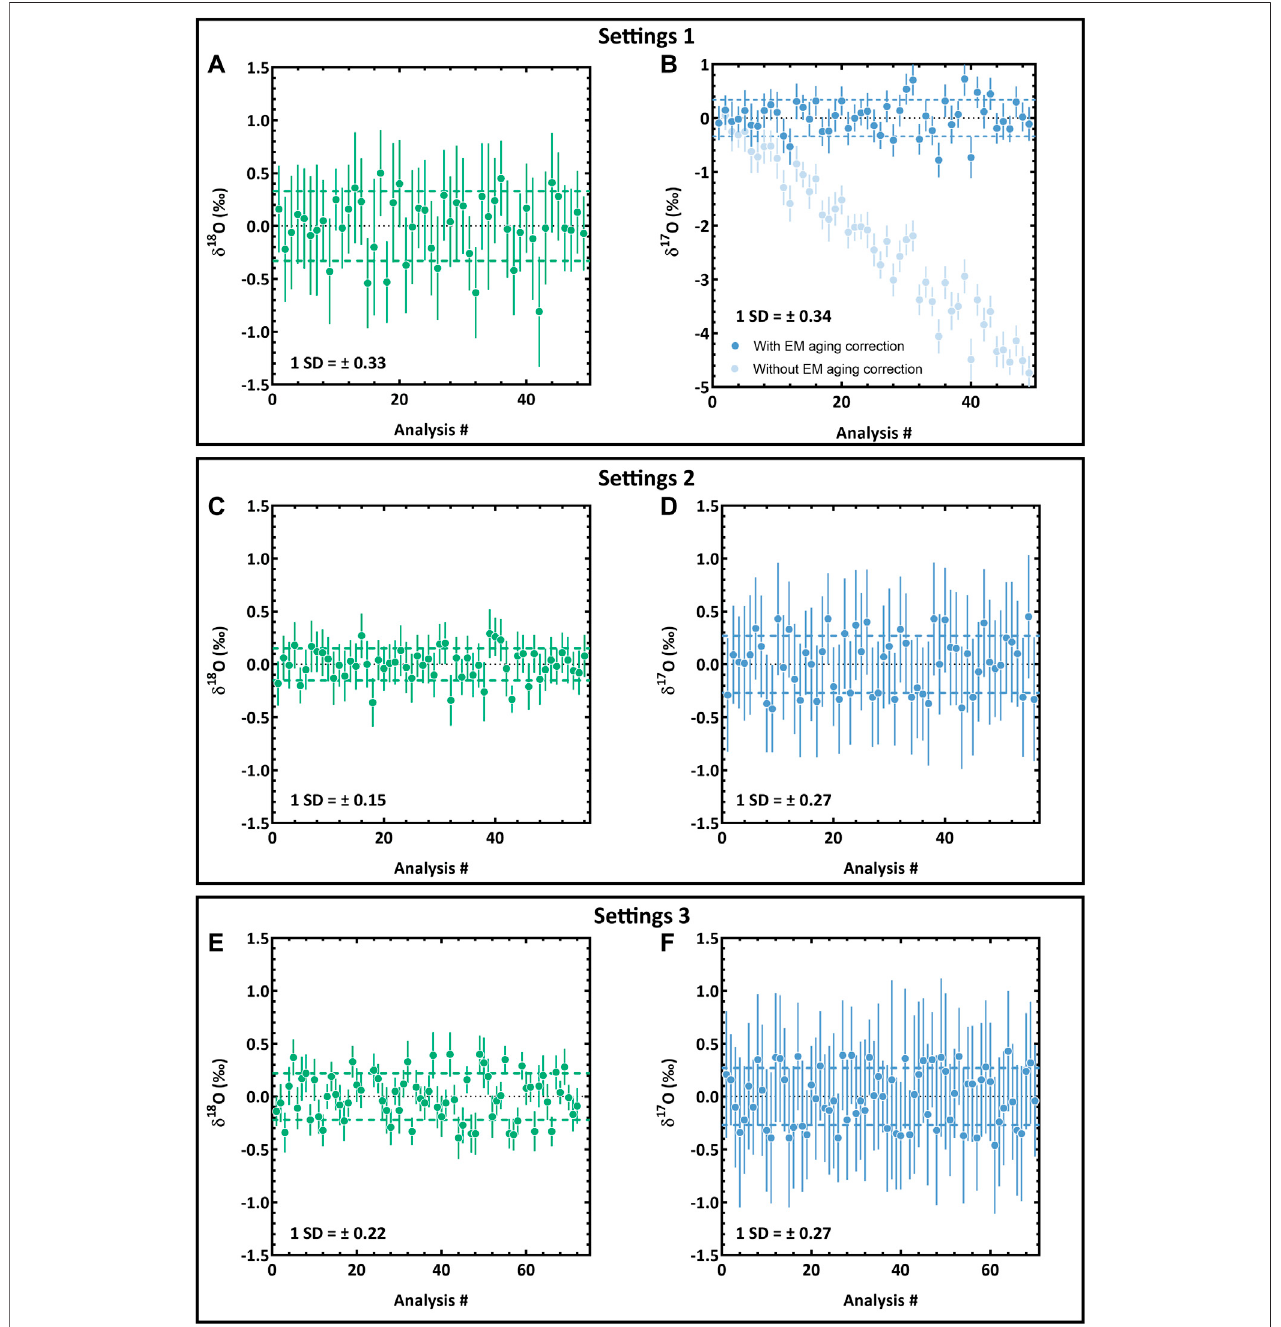
FIGURE2| Reproducibilityof δ 18 O (A,CandE) ;and δ 17 O (B,DandF) measurementsinSanCarlosolivinestandardforthethreedifferentSIMSanalyticalsettings (see text for details). Error bars are ± 2SE (standard error). Dotted lines corresponds to the external reproducibility ( ± 1SD).